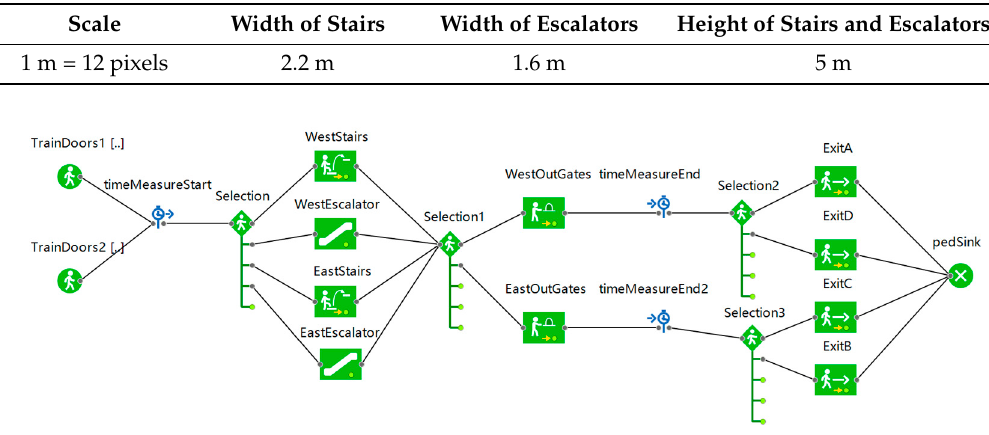
Table 3. Environment model parameters of the station.